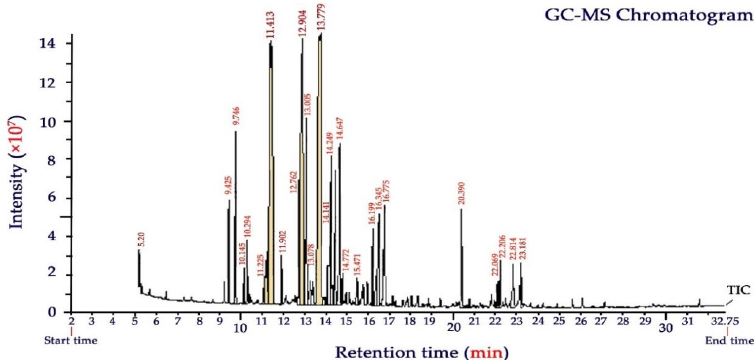
Figure 2. GC–MS chromatogram of Yarrow ( Achillea millefolium L.) essential Figure 2. GC – MS chromatogram of Yarrow ( Achillea millefolium L.) essential oil Table 2. Identified chemical components of Yarrow ( Achillea millefolium L.) essential oil.